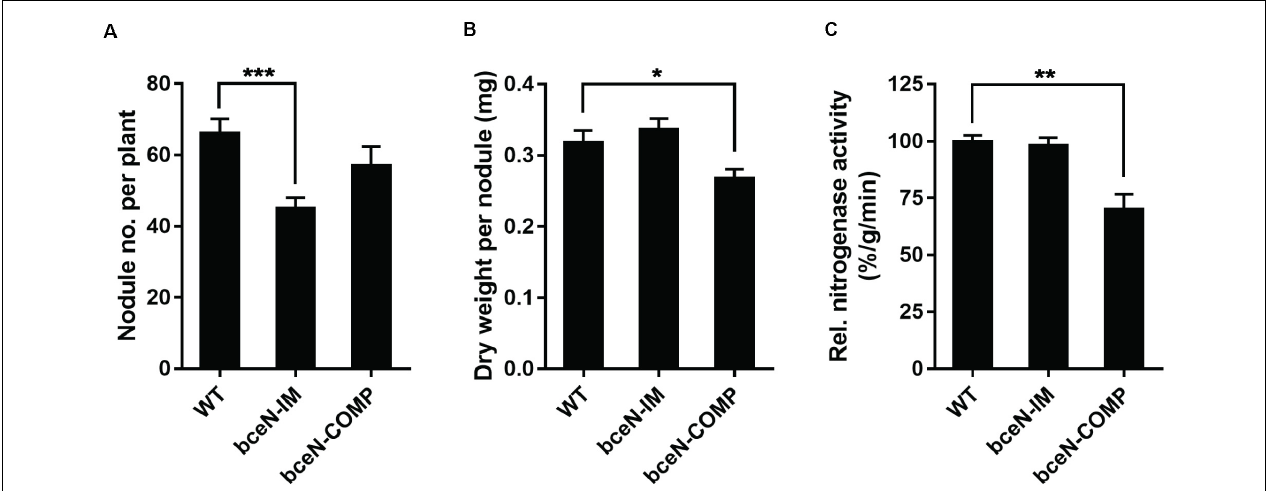
FIGURE 5 | The symbiotic properties of P. vulgaris plants inoculated with P. phymatum wild-type (WT), bceN mutant (bceN-IM), and the complemented (bceN-COMP) strains. Number of nodules per plant (A) , dry weight per nodule (B) , and relative nitrogenase activity (C) were analyzed 21 dpi. The results are a combination of at least two independent experiments with two biological replicates of each strain, n = 16. Error bars indicate the standard error of the mean (SEM). *** p = 0.0007; * p = 0.0321; ** p = 0.006.